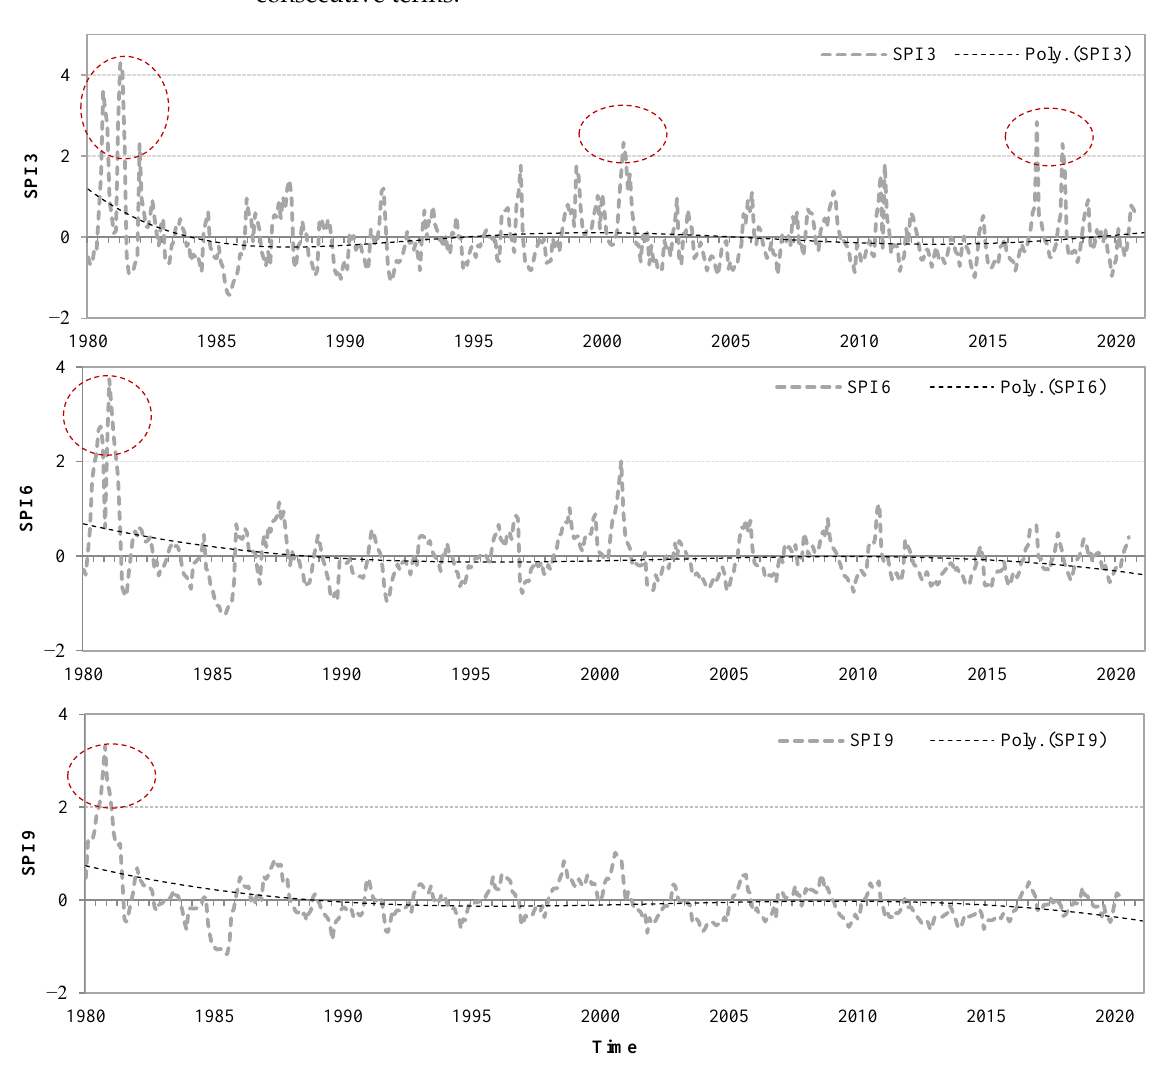
Figure 3. Drought time series at 3, 6, and 9 monthly SPI for the Chau Doc meteorological station. The best-fit lines using polynomial (Poly).